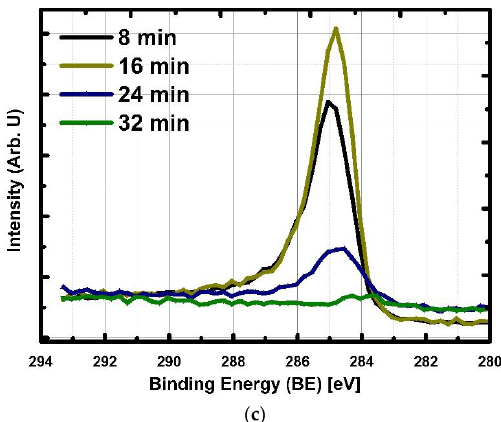
Figure 2. XPS main photoelectron lines of ( a ) oxygen (O) 1s and ( b ) tungsten (W) 4f ( c ) carbon (C) 1s measured at 25 °C under UHV conditions with 650 and 120 X-ray photons for baseline establishment of fitting parameters for further detailed quantification analysis. C 1s measurements was conducted under 10 −6 mbar O 2 partial pressure at 200 °C to clean the surface from carbon groups without damaging the surface stoichiometry.